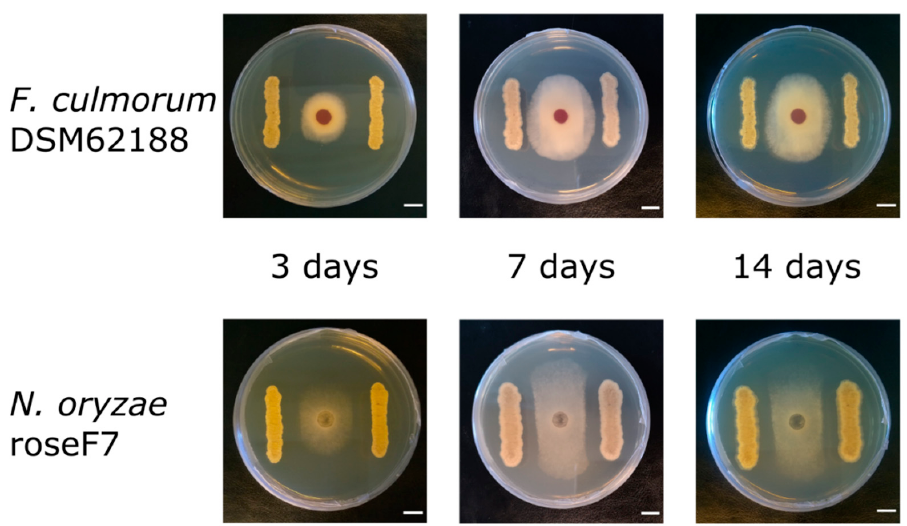
Figure 2. Inhibition of fungal growth by Streptomyces sp. MW-W600-10. Representative pictures of the MW-W600-10 strain in co-culture with both examined fungi on MHA plates. Pictures from 3 day Streptomyces pre-culture with MW-W600-10 inoculated at 25 mm from the center of the plates. An 8 mm agar puck with fungal mycelium was placed at the plate center. Pictures were taken at the 3rd, 7th, and 14th day of co-culture. The scale bar represents a distance of 10 mm.